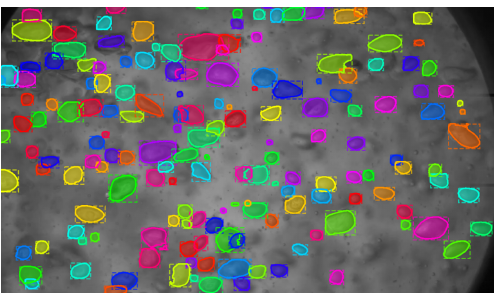
Figure 12. Bubble segmentation using pre-trained Mask R-CNN.